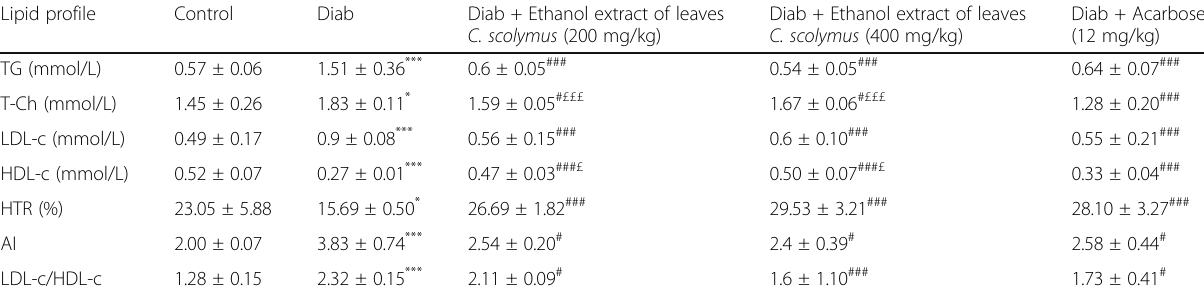
Table 8 Effect of Cynara scolymus leaves extracts on plasma lipid profile levels of experimental groups of rats Lipid